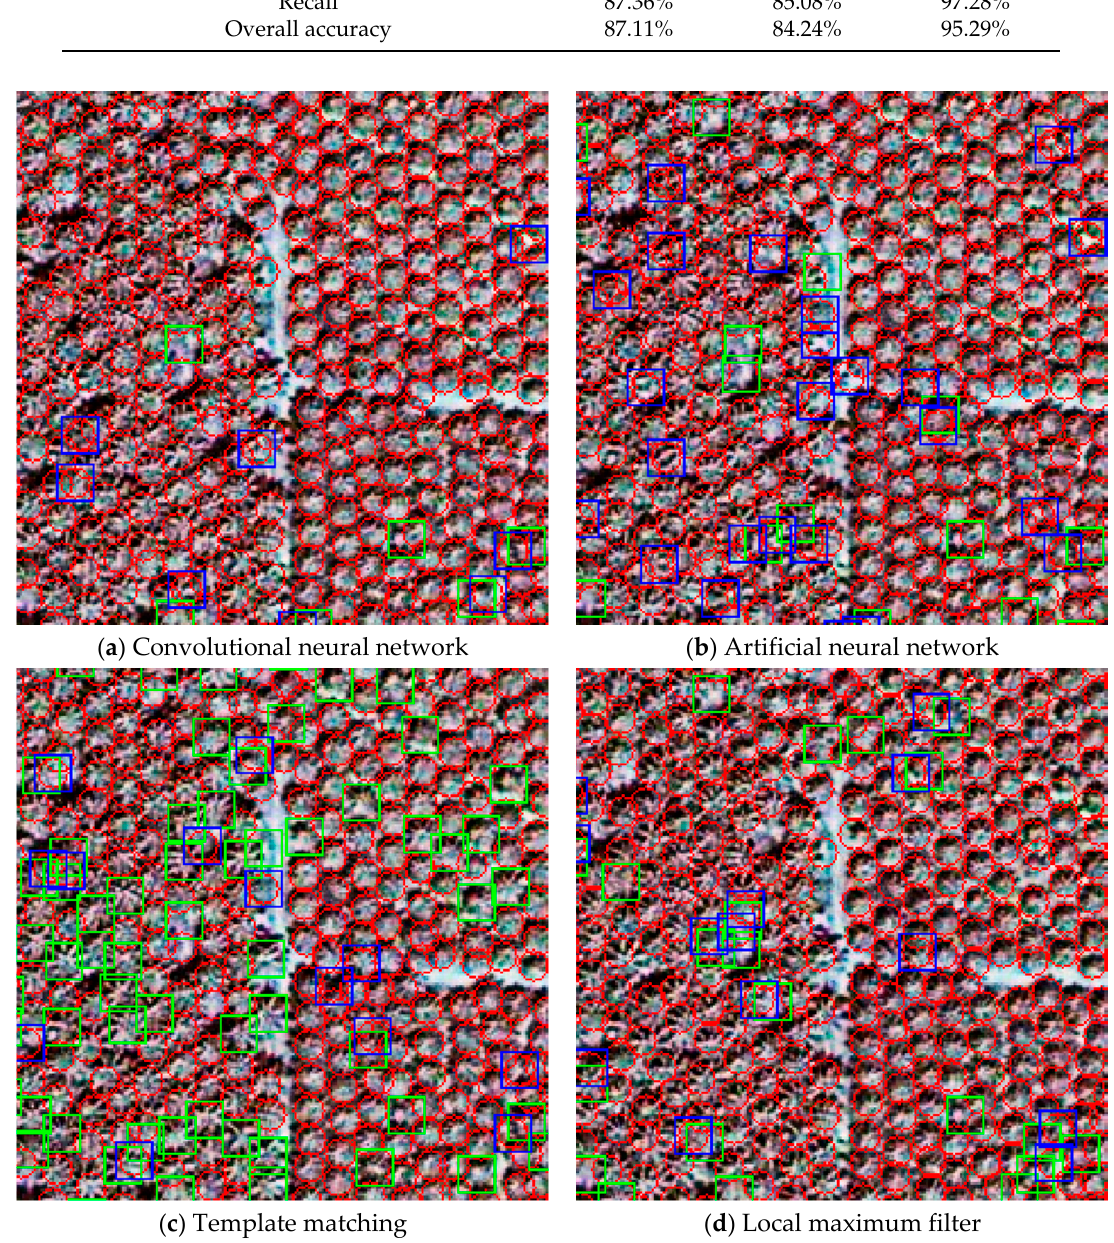
Figure 6. Detection image of each method for region 1 (extracted area). Each red circle denotes a detected palm tree. Each green square denotes a palm tree in ground truth that cannot be detected correctly. Each blue square denotes a background sample that is detected as a palm tree by mistake.